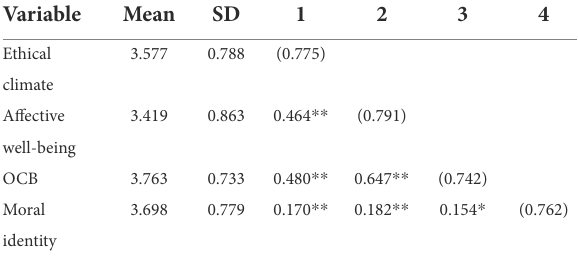
TABLE 2 Correlation matrix of the study’s variables.